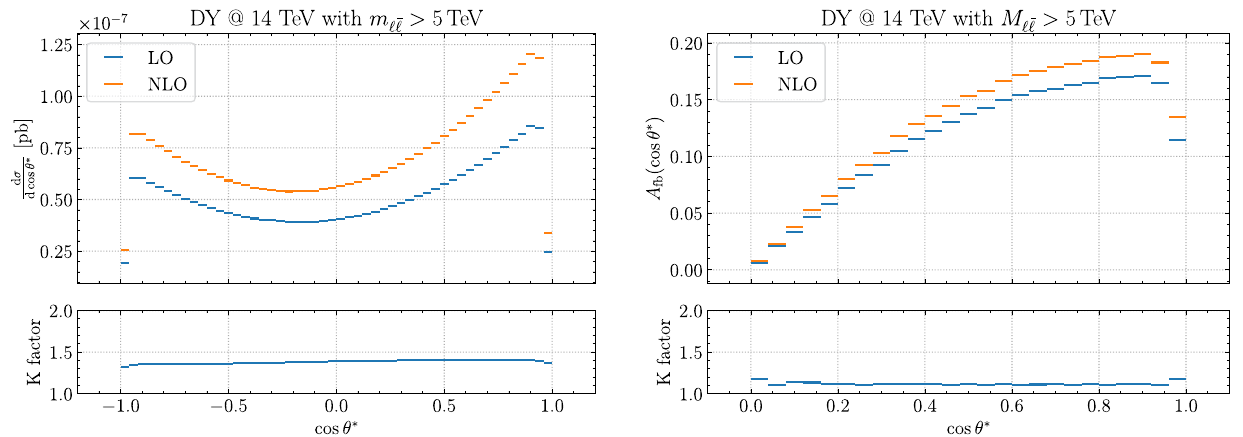
Fig. 5 Same as Fig. 3 now comparing the LO result to the NLO QCD result obtained using MadGraph5_aMC@NLO . The K -factor is shown in the lower panel.